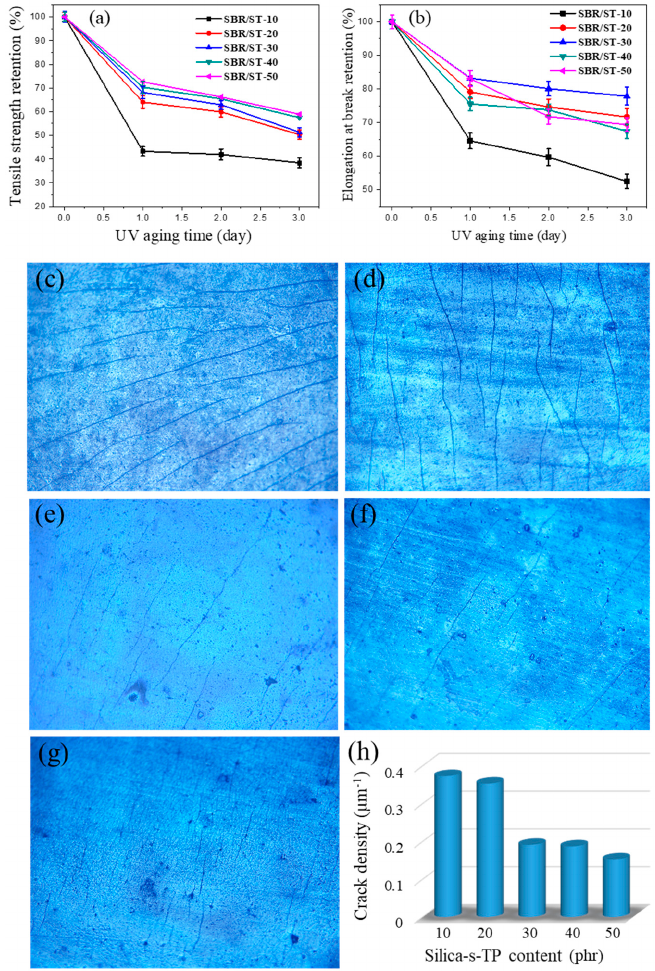
Figure 7. ( a , b ) The retention of mechanical properties of SBR / silica-s-TP composites before and after UV aging at 50 °C; ( c – g ) the optical photomicrographs (50-fold) of UV exposed (3d) SBR composites containing di ff erent silica-s-TP content: ( c ) 10 phr, ( d ) 20 phr, ( e ) 30 phr, ( f ) 40 phr and ( g ) 50 phr; ( h ) the tendency chart of crack density vs. silica-s-TP